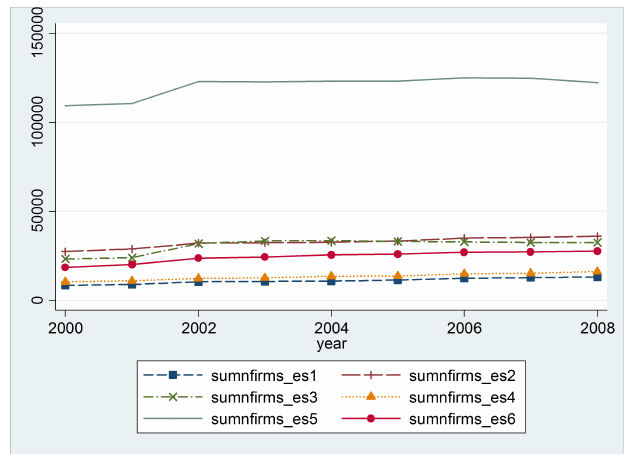
Figure 3: Number of exporting firms exporting to the 45 selected destinations, by region